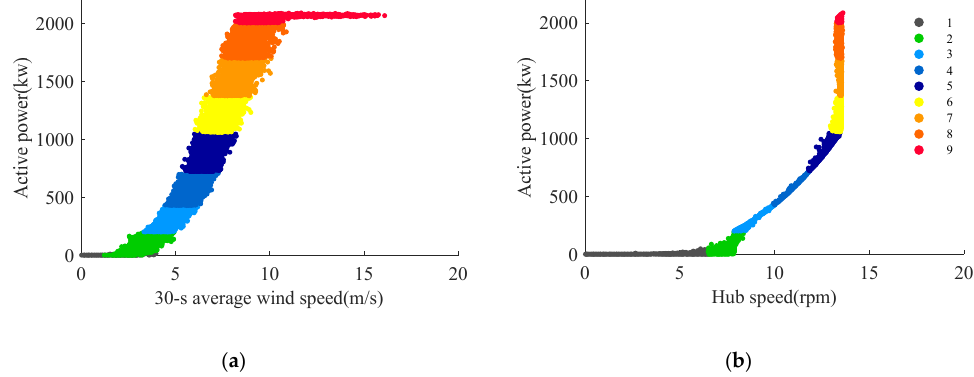
Figure 7. The working condition classi fi cation of the drivetrain: ( a ) 30-s average wind speed vs. active power; ( b ) hub speed vs. active power.